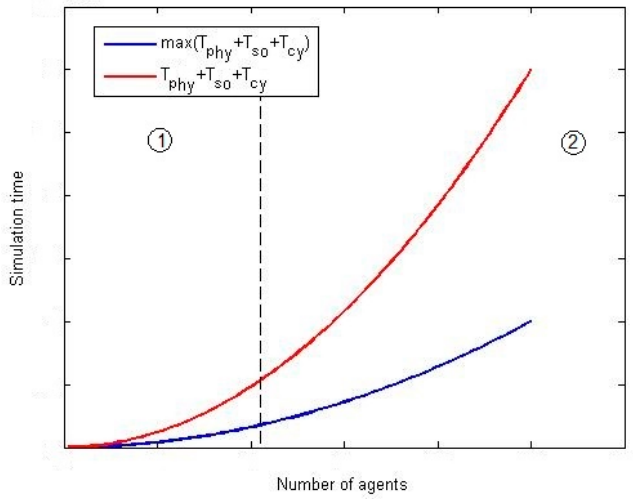
Figure 9. Generic graphic of the evolution of the simulation time.